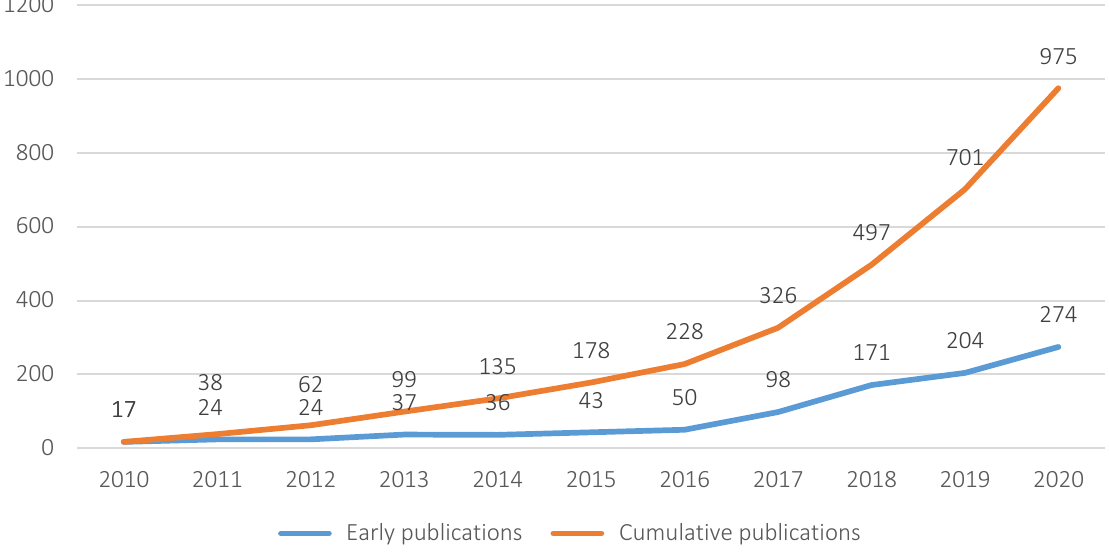
Figure 1. Number of published documents on sustainable